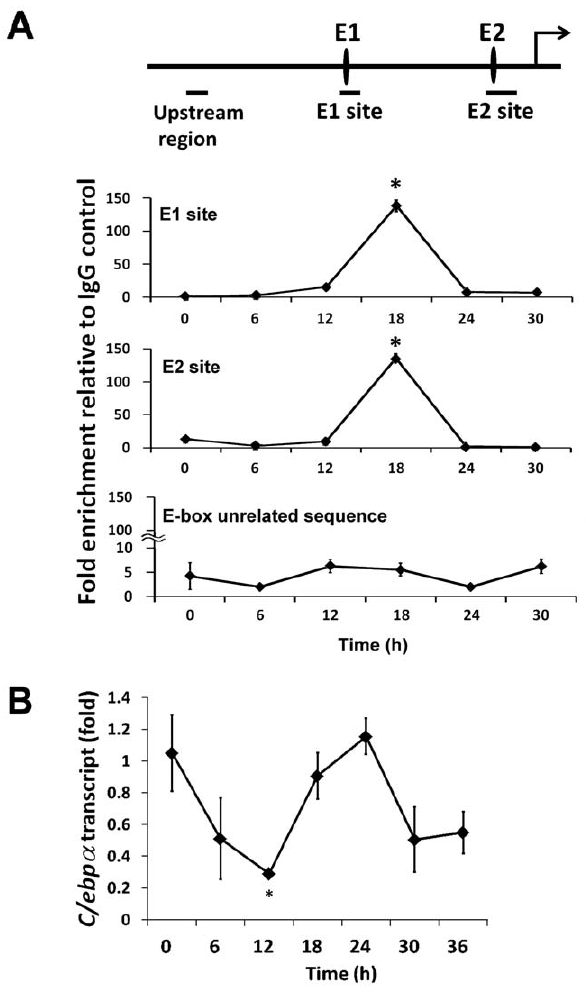
Figure 4. CLOCK binds to E1 and E2 sites in living cell. (A) Chromatin immunoprecipitation (ChIP) assay for CLOCK and E-boxes of C/ebp a promoter. E-box sites are shown as ovals on the schematic. Horizontal bars indicate amplified regions (E-box unrelated sequence, from 2 2239 to 2 2063; E1 site, from 2 1240 to 2 1128; E2 site, from 2 295 to 2 137.) NIH 3T3 cells were rapidly sampled and processed